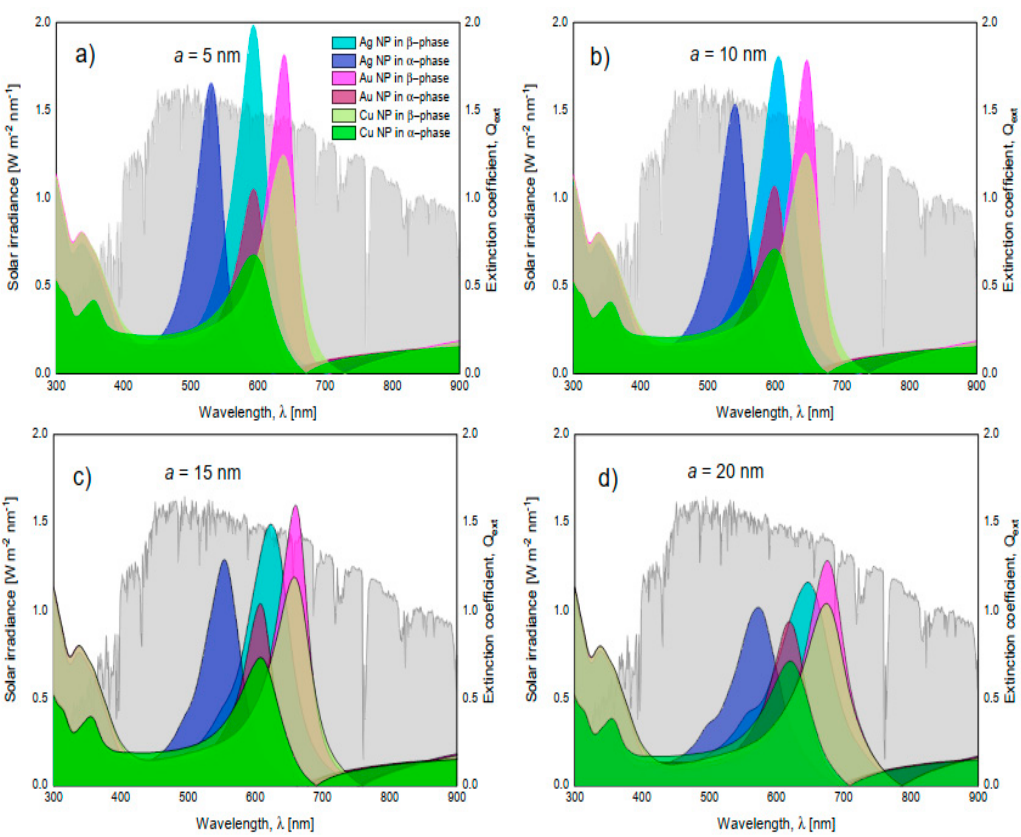
Figure 10. Superposition of the solar spectral irradiance at an air mass of 1.5 (in gray and associated to the left axis) and the extinction coefficients of MoO 3 films in its alpha and beta phase (right axis). ( a ) nanoparticles with a radius of 5 nm, ( b ) nanoparticles with a radius of 10 nm, ( c ) nanoparticles with a radius of 15 nm, and ( d ) nanoparticles with a radius of 20 nm. In all these cases the f = 5%.